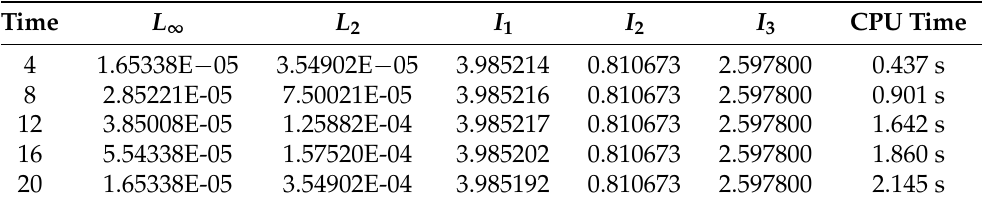
Table 3. Invariants and errors using Sinc-collocation when δ t = 0.1, c = 0.01, N = 80 and − 40 ≤ x ≤ 60. We used xEy to denote x × 10 y